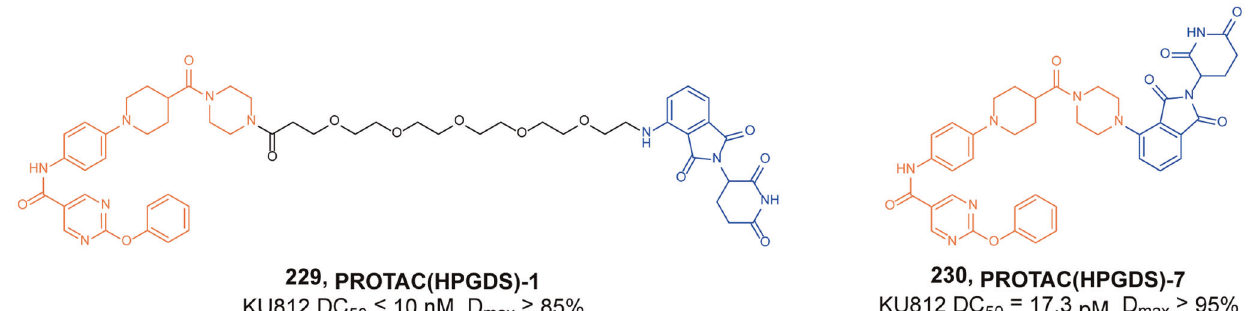
Fig. 76 The representative PROTACs targeting